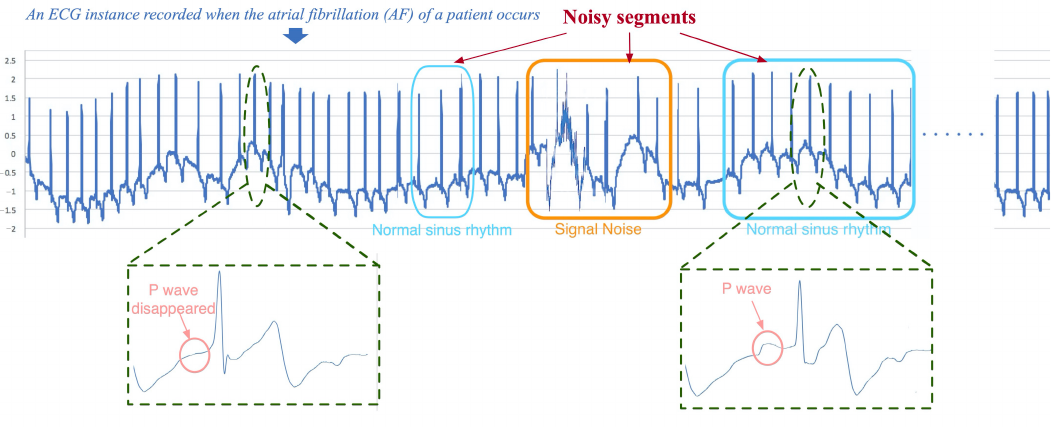
Figure 1. An example of a health-condition monitoring record with noisy segments whose label is Atrial